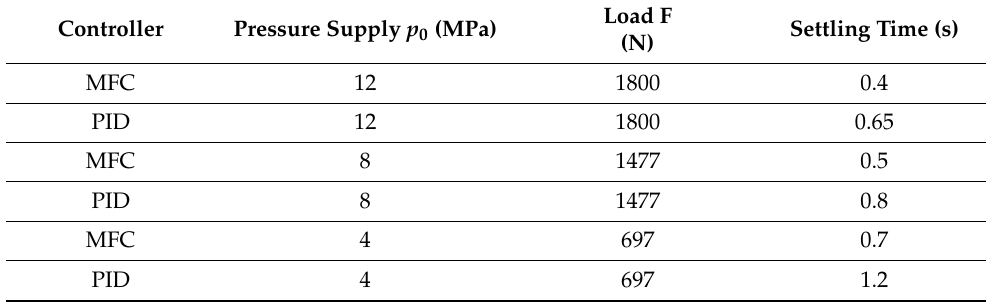
Table 2. IAE and mechanical force comparison.